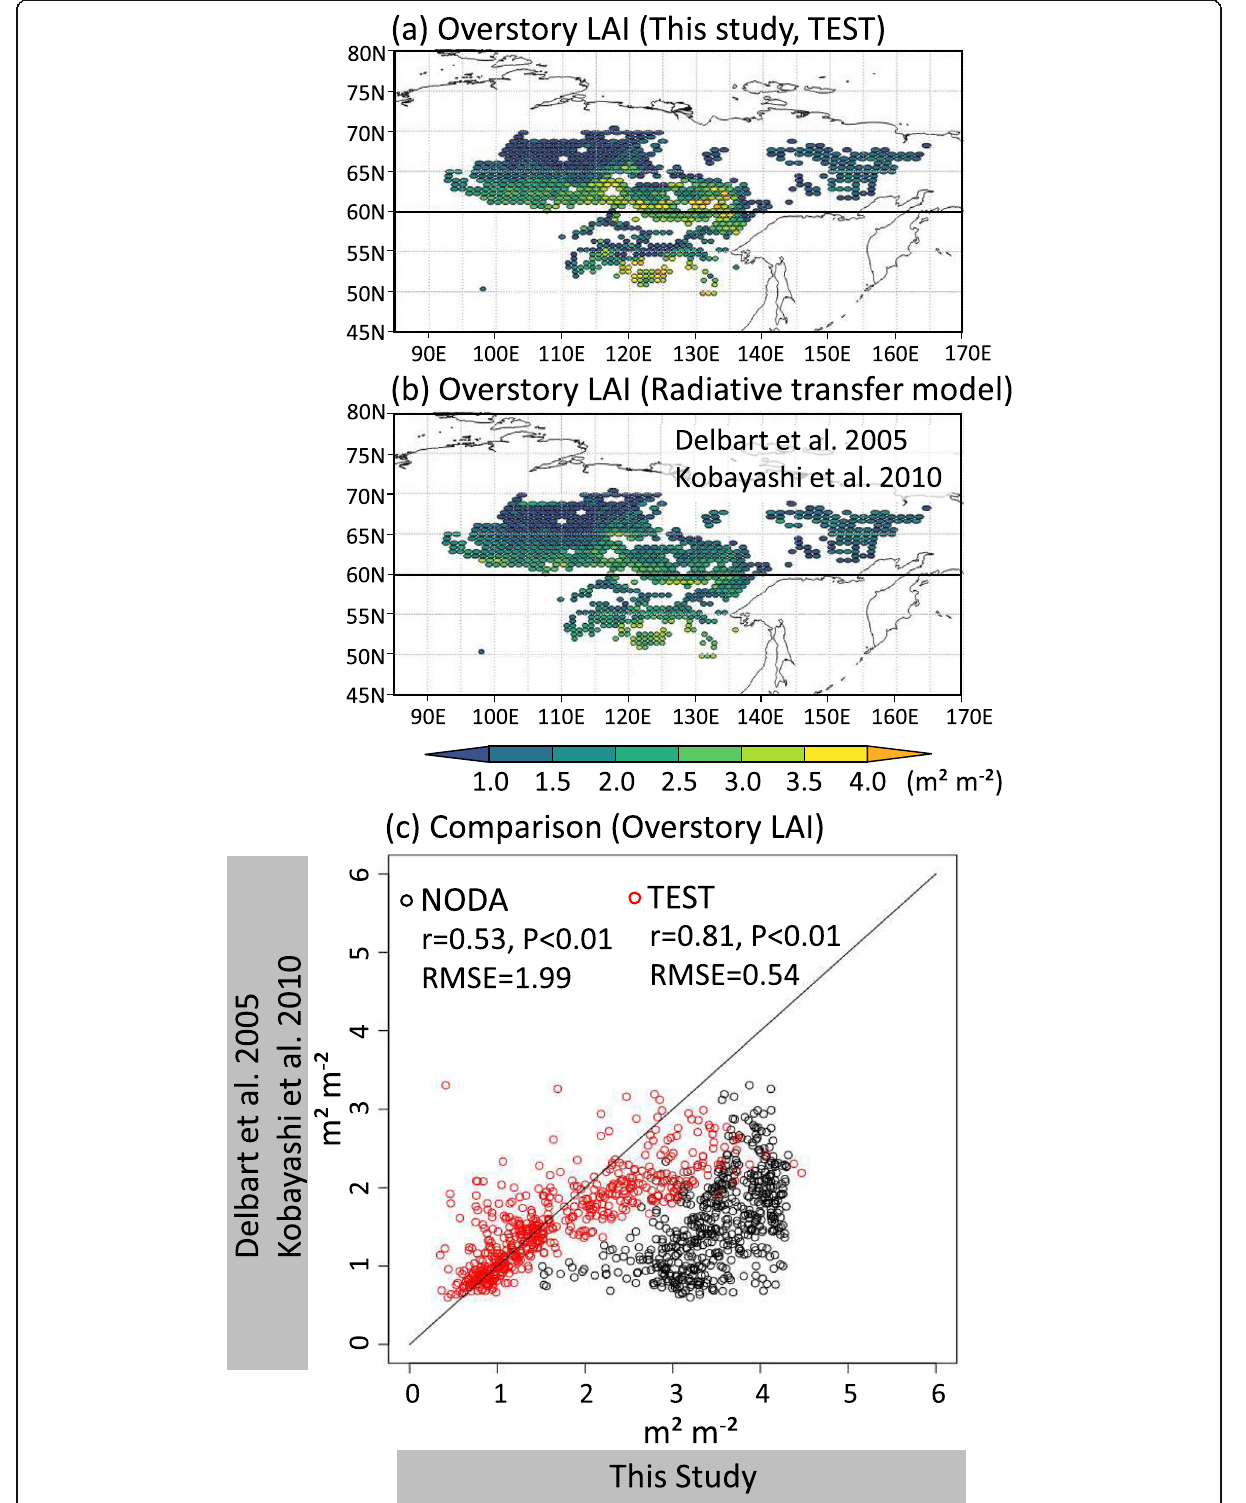
Fig. 4 Overstory LAI (annual maximum of median). a This study (TEST), b estimation with three-dimensional radiative transfer model (Delbart et al. 2005; Kobayashi et al. 2010), and c scatter plot of this study against the estimates from Delbart et al. (2005) and Kobayashi et al.